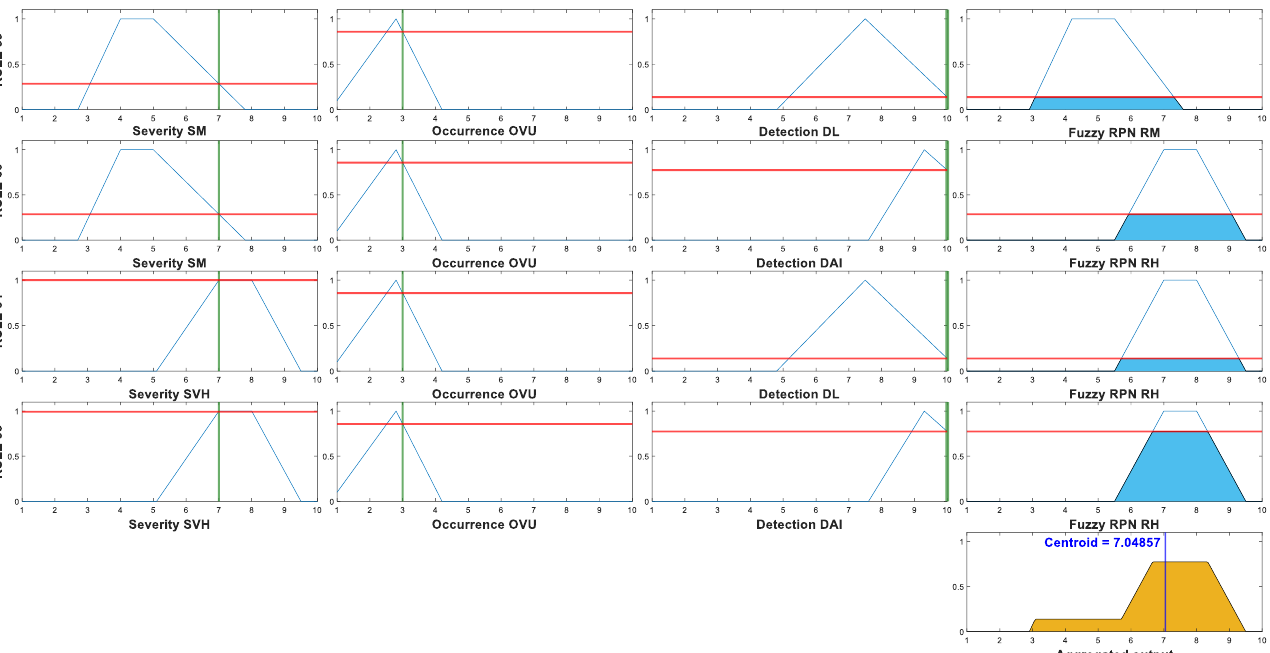
Figure 10. Fired fuzzy rules and aggregated output for failure modes FM32 and FM39.